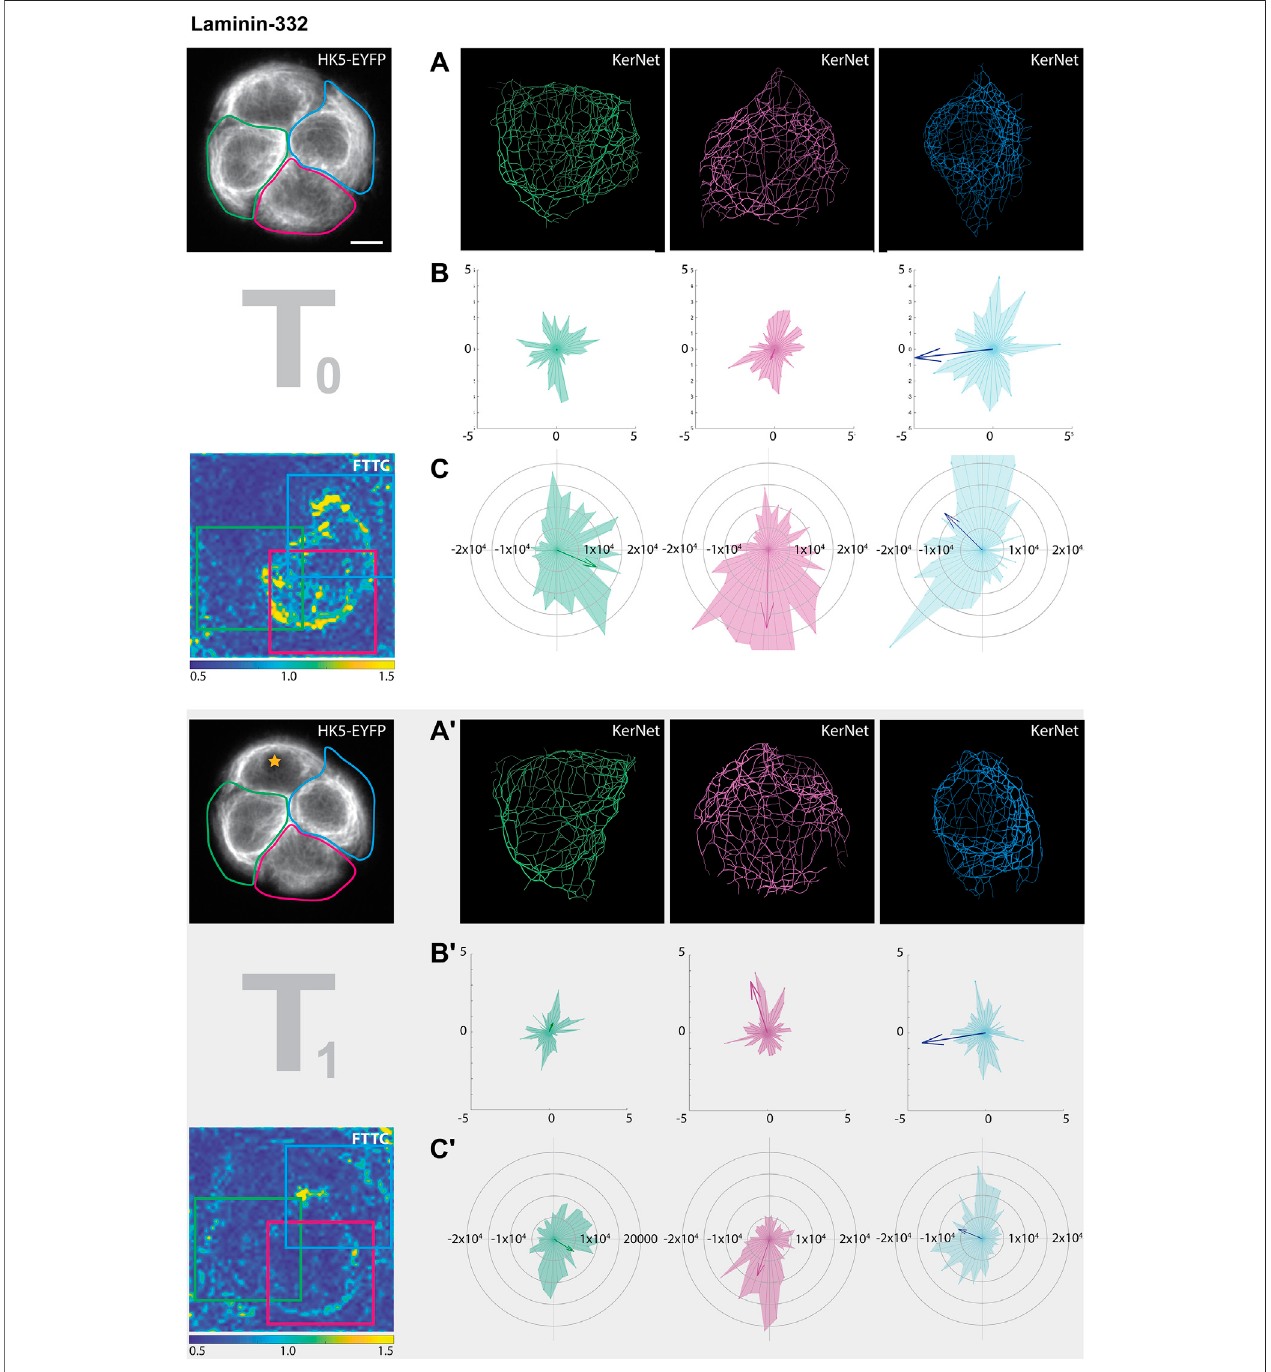
FIGURE7| Photoablation affects KFsegment orientation and traction forces differently. Thedataset for this fi gure corresponds tothatshown intheright columns of Figure 5 (partially shown here at left). In this instance, however, the cellular ablation response of segmented fi laments was analyzed in single cells within the HaCaT B10 cell group growing on laminin-332. The different cells are color coded in green, red and blue (from left to right). (A,A ’ ) Show the digitally segmented 3D networks before and after photo-oxidation. (B,B ’ ) Depict the corresponding radial histograms of KF segment orientation and sum vectors in relation to the center of the micropattern. (C,C ’ ) Present the corresponding traction force vectors in the areas delineated by colored squares. They are represented by radial histograms and the resulting sum vectors are depicted as arrows. Scale bar: 10 μ m.